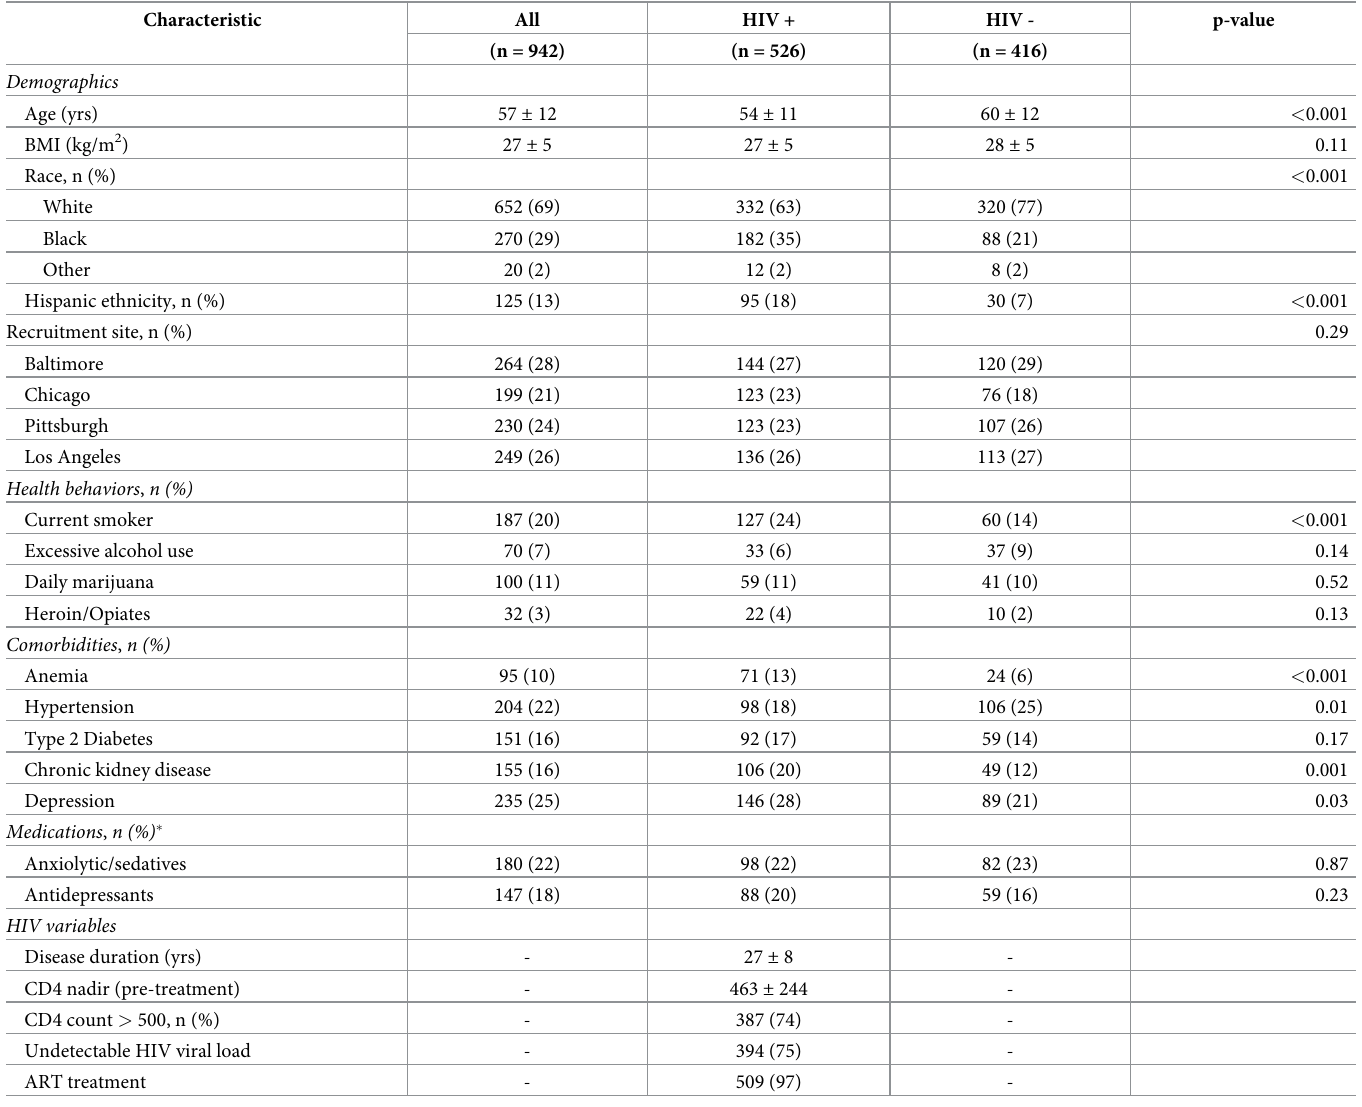
Table 1. Comparison of men with and without HIV by